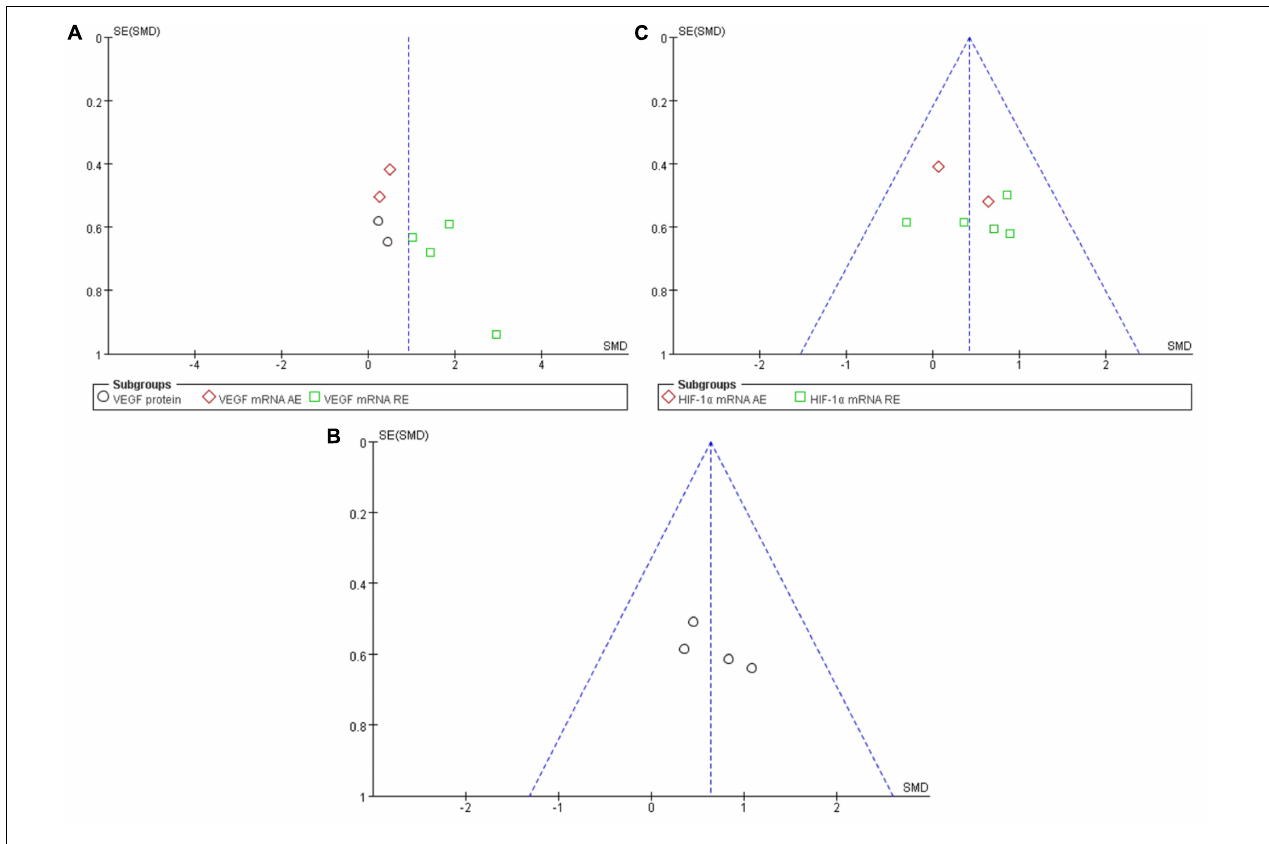
FIGURE 6 | Funnel plot of publication bias for the effect of resistance exercise on the VEGF (A) , VEGFR-2 (B) and HIF-1 α (C)